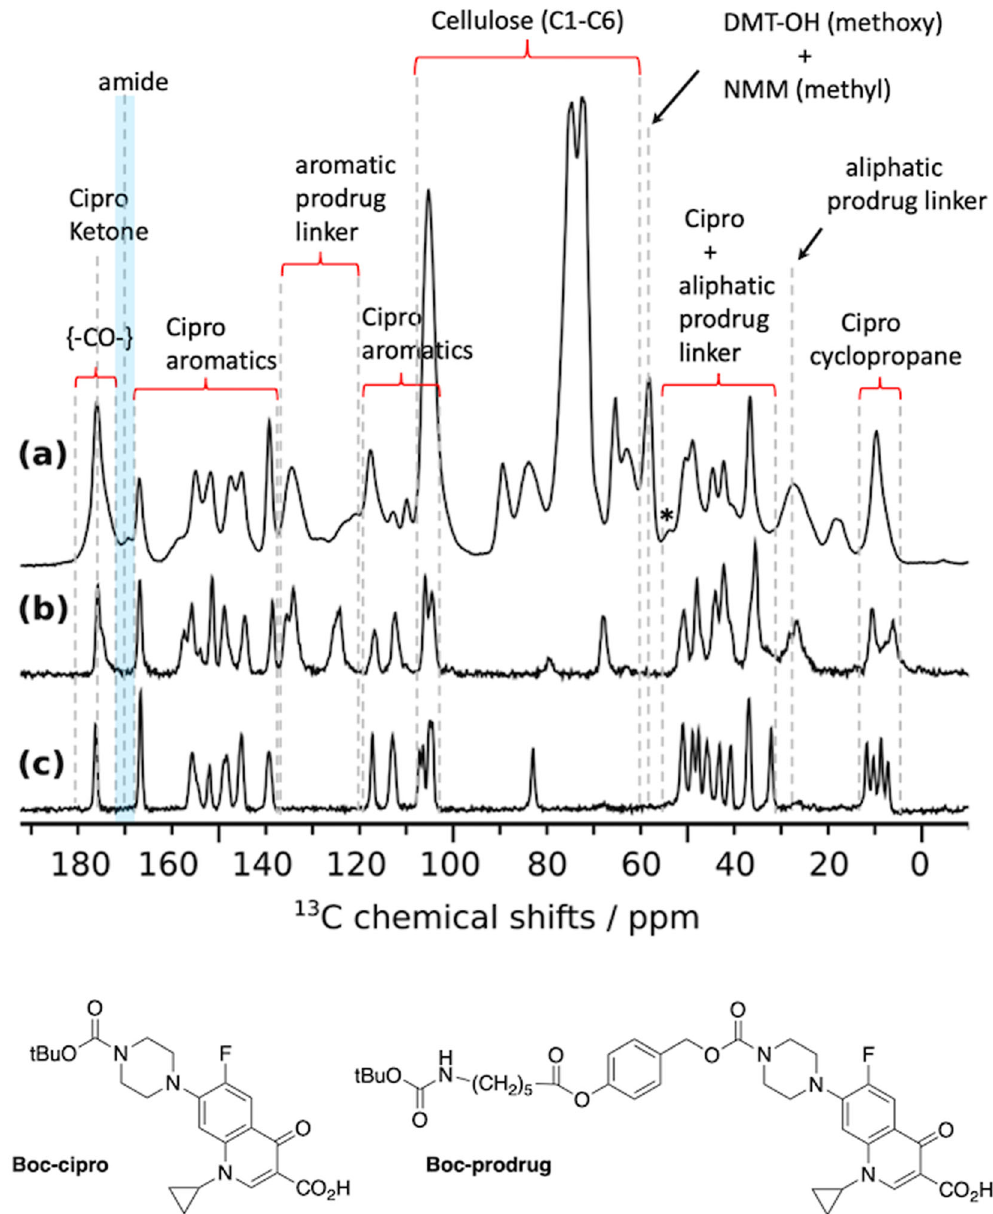
Fig. 5 13 C-CPMAS spectroscopy. a DNP-enhanced quantitative 13 C-CPMAS spectrum of CNF-prodrug-pH6, acquired with the MultiCP pulse sequence 79 . The DNP sample was prepared by impregnation with the radical solution. b , c Solid-state 13 C-CPMAS spectra (without DNP) of b Boc-prodrug and c Boc- cipro. Both samples were pure powders. All three spectra were recorded at 100 K. Spinning sidebands are marked with asterisks. Chemical structures of Boc-prodrug and Boc-cipro are given at the bottom of the fi